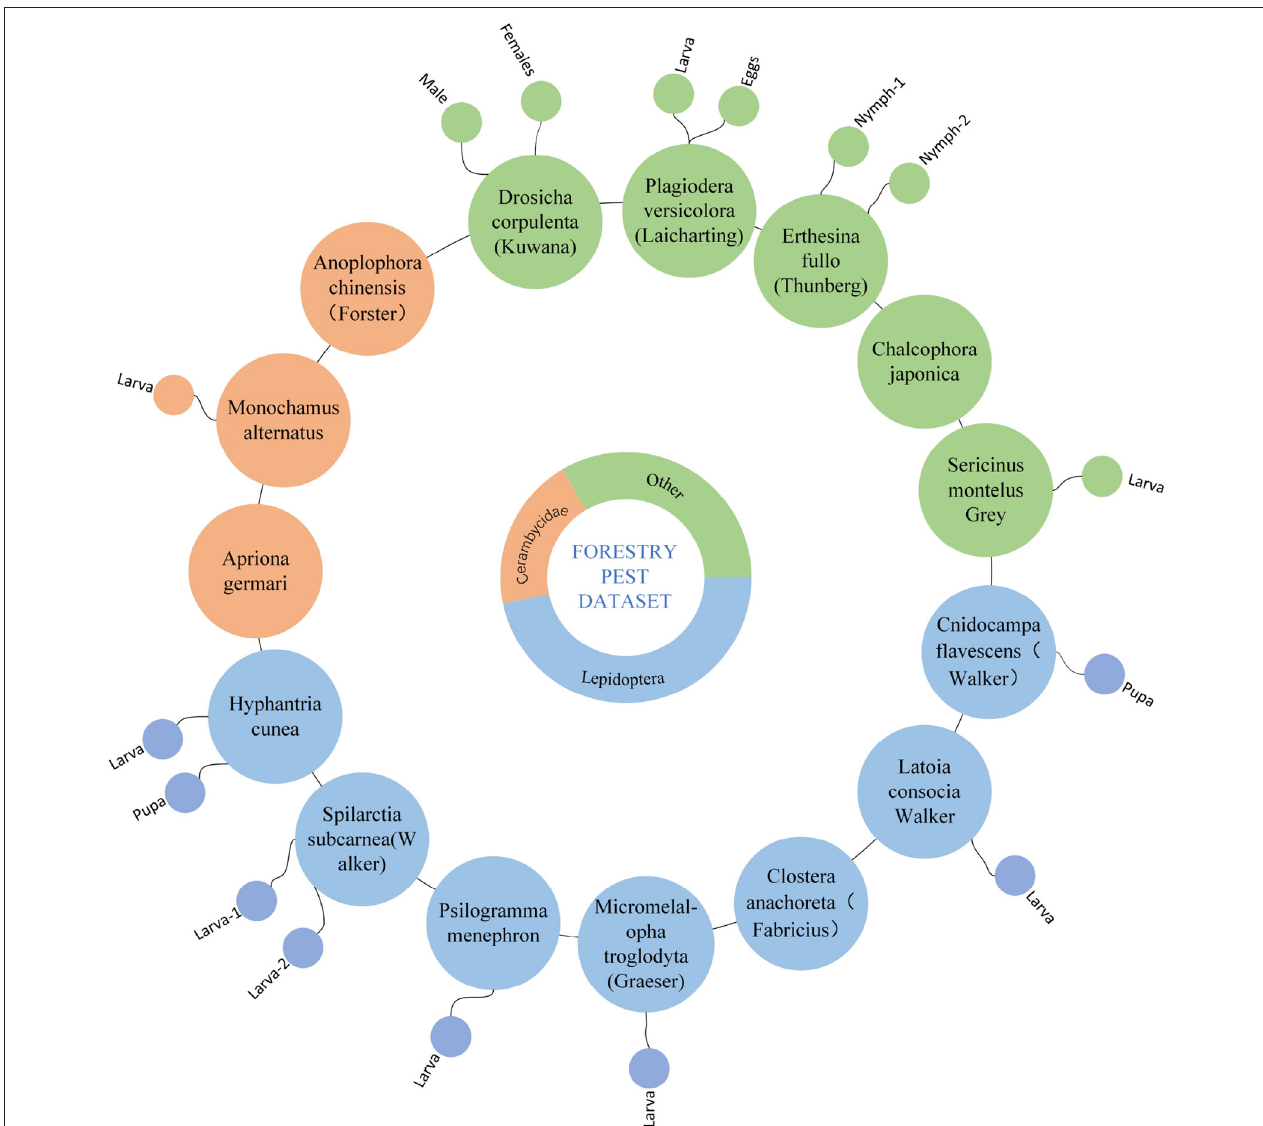
FIGURE 2 | The classification structure of Forestry Pest